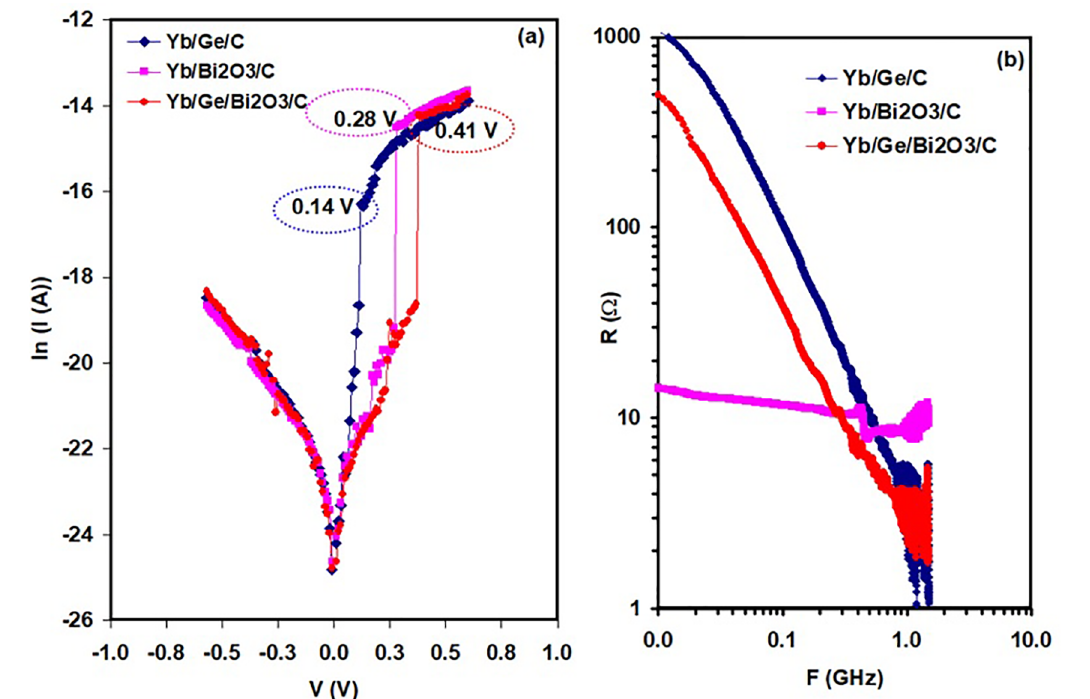
O /C and Yb/Ge/Bi 2 3